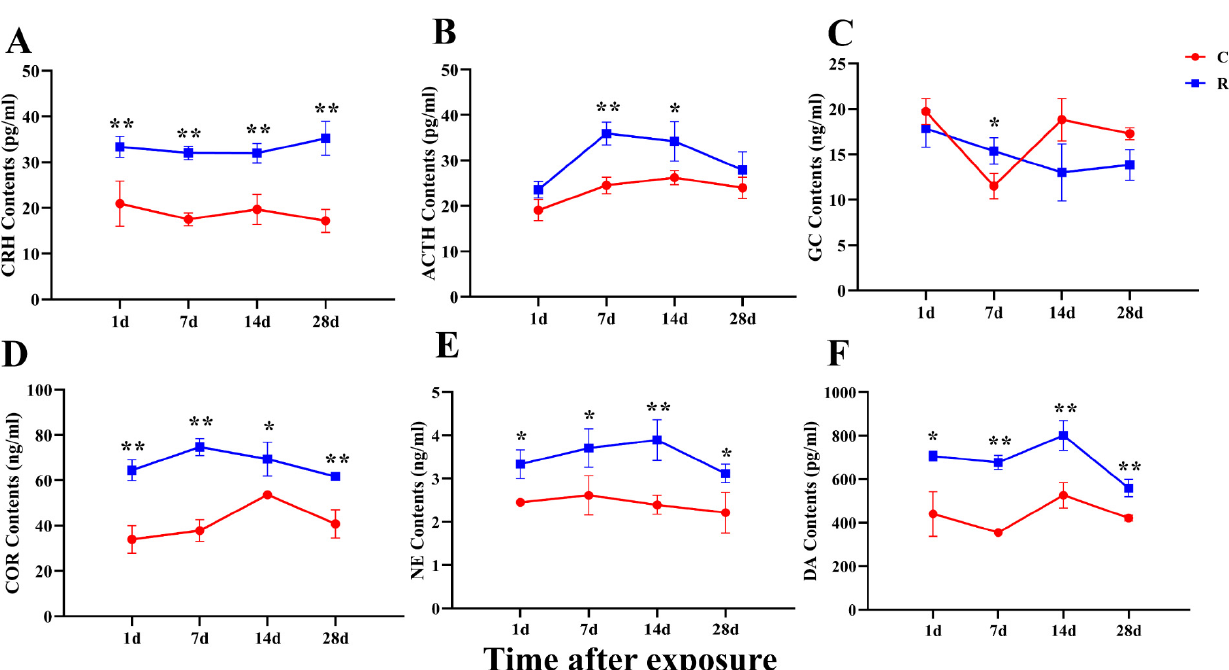
Figure 6. Changes in stress-related hormones in rats’ serum after S-band radiation. ( A ) CRH; ( B ) COR; ( C ) NE; ( D ) DA; ( E ) ACTH; ( F ) GC. Significance signs were classified according to p -value: * p < 0.05 and ** p < 0.01.